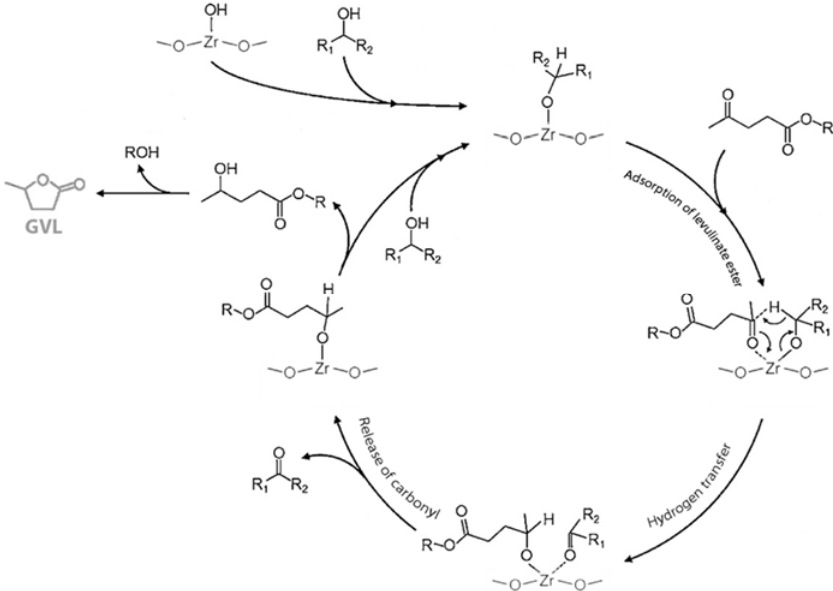
Table 5. Representative heterogeneous catalysts in the CTH of LA and its derivatives using different alcohols as hydrogen donors.